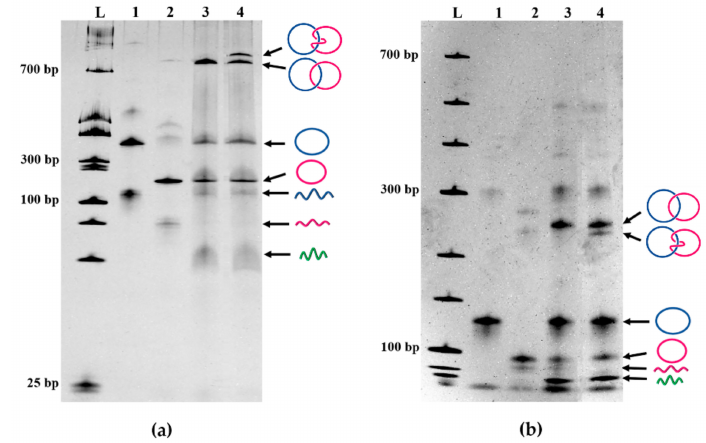
Figure 2. Verification of Lk 1 structure of DNA catenane fabricated by two-holder method. ( a ) Analysis of the catenation products by 14% dPAGE and ( b ) analysis of the same products by 4% dPAGE. For both ( a , b ), lane 3 shows the products obtained with the use of both HS I and HS II , whereas lane 4 is for the reaction using only HS I . In lanes 1 and 2, a single ring, independently prepared from each quasi-ring, is analyzed to show its position in the